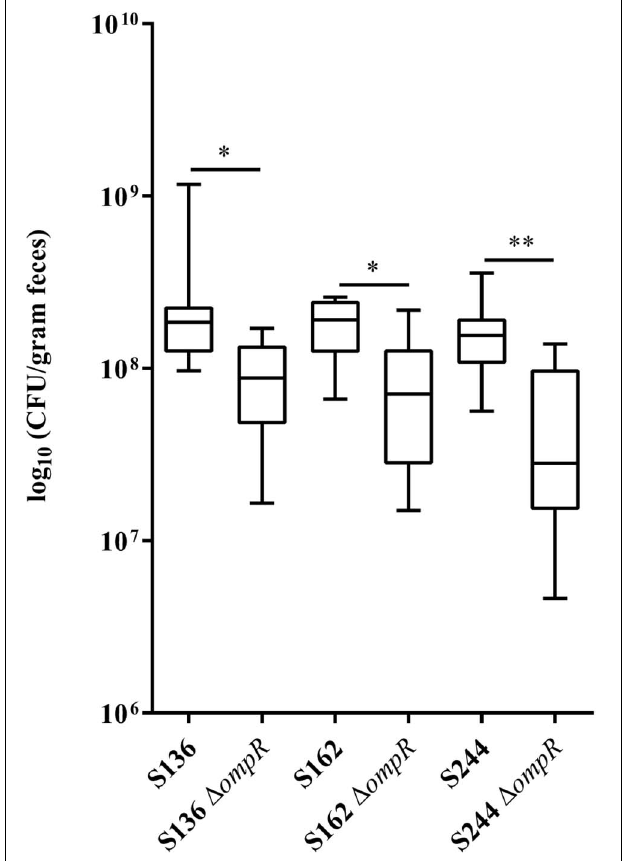
FIGURE 2 | Ability of AIEC WT and (cid:49) ompR mutants to colonize the intestine of CEABAC10 mice. Bacterial load in the feces of CEABAC10 mice (8 mice per group) infected with WT and (cid:49) ompR AIEC strains at 7-day post-infection. The quantification of AIEC bacteria in the feces of CEABAC10 mice are expressed in CFU/gram feces. Representation in box and whiskers (Min to Max); Mann Whitney test realized between WT and ompR mutant groups; ∗ p < 0.05 and ∗∗ p <